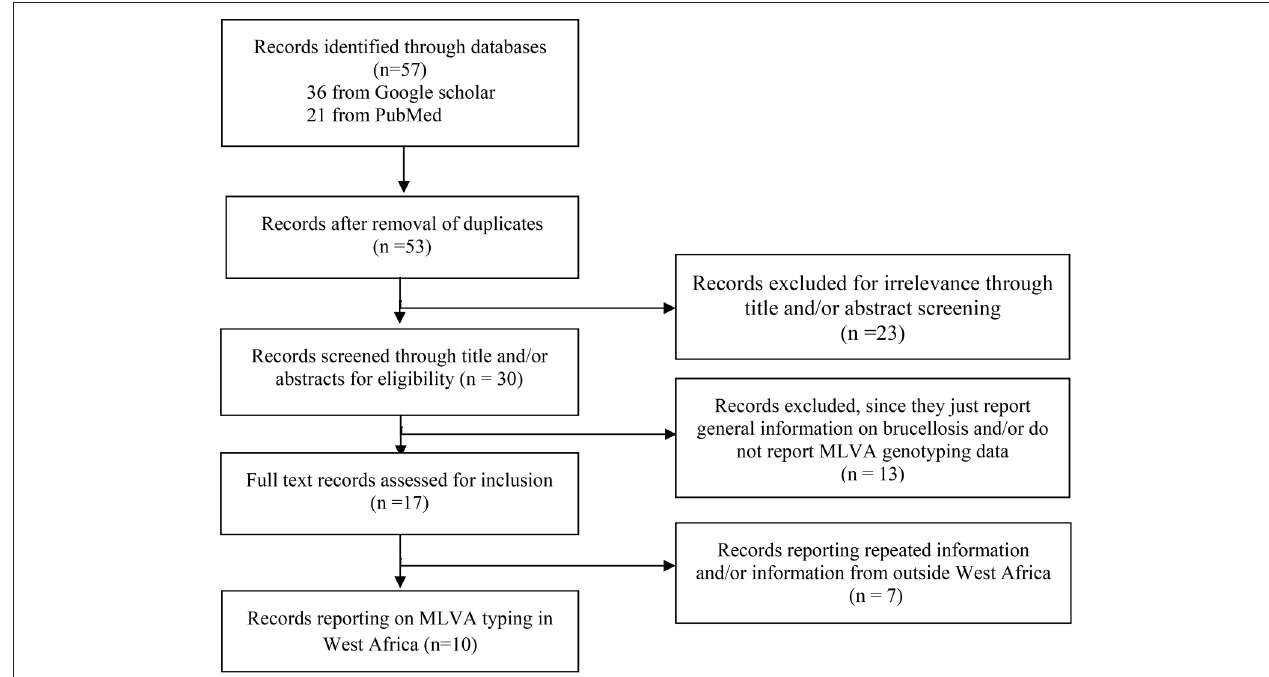
FIGURE 2 | Flow diagram presenting a summary of the literature search on genotyping of field strains of Brucella from West Africa and other parts of Africa.